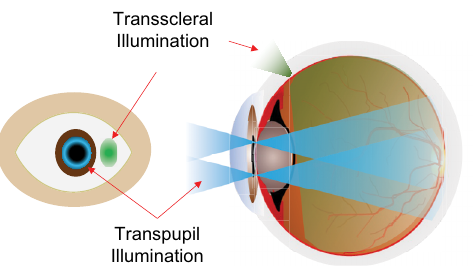
Figure 1: Comparison of annular illumination, where an annulus-shaped field of light is focused onto the cornea and then diverges to both illuminate the retina, and the new technique of trans-scleral illumination where a beam of light is focused onto a spot on the sclera which di ff uses and uniformly illuminates the retinal